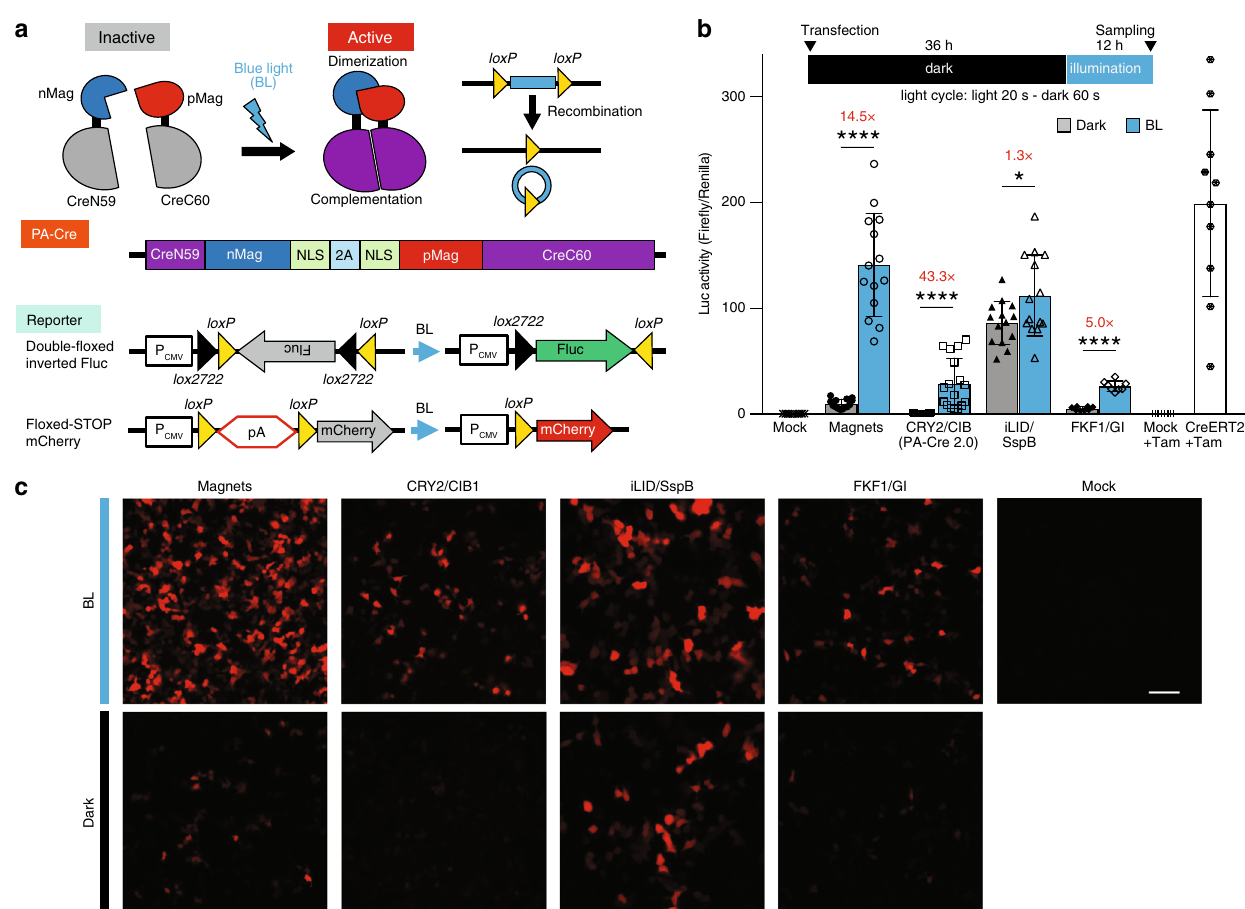
Fig. 1 Comparison of multiple light-activated dimerization systems in photoactivatable Cre recombinase. a Schematic representation of photoactivatable (PA)-Cre system and its reporter constructs. Split Cre (59/60) are complemented along with nMag – pMag dimerization upon blue-light illumination (BL blue light, NLS nuclear localization signal, 2A P2A self-cleaving peptide sequence, P CMV cytomegalovirus promoter, Fluc Fire fl y luciferase, pA polyadenylation transcriptional “ stop ” (poly-A) signal repeated sequence). b Comparison of PA-Cre with various blue-light photoreceptors using luciferase (Luc) assay. Upper diagram shows experimental protocol used for Luc assay (blue LED, 447.5 nm, 8.28 W/m 2 , repeated 20 s light and 60 s dark for 12 h). Luc assays were conducted with double- fl oxed inverted Fluc reporter in HEK 293T cells. The herpes simplex virus thymedine kinase (HSV-TK) promoter- Renilla Luc plasmid was co-transfected as a transfection control to normalize Fire fl y Luc activity. CreERT2 vector and pcDNA3.1 empty vector (Mock) treated with 1 µ M tamoxifen (Tam) addition 36 h after the transfection were used as positive and negative controls, respectively (* P < 0.05; **** P < 0.0001; dark v.s. BL using Two-tailed t test, biologically independent samples; Mock, Magnets, iLID/SspB: n = 14, CRY2/CIB n = 17, FKF1/GI n = 8, Mock + Tam, CreERT2 + Tam: n = 10, mean ± s.d.). c Fluorescence images of HEK 293T cells expressing multiple versions of PA-Cre constructs and Floxed- mCherry reporter transiently ( n = 3 – 7). Scale bar, 100 μ m. Source data are provided as a Source